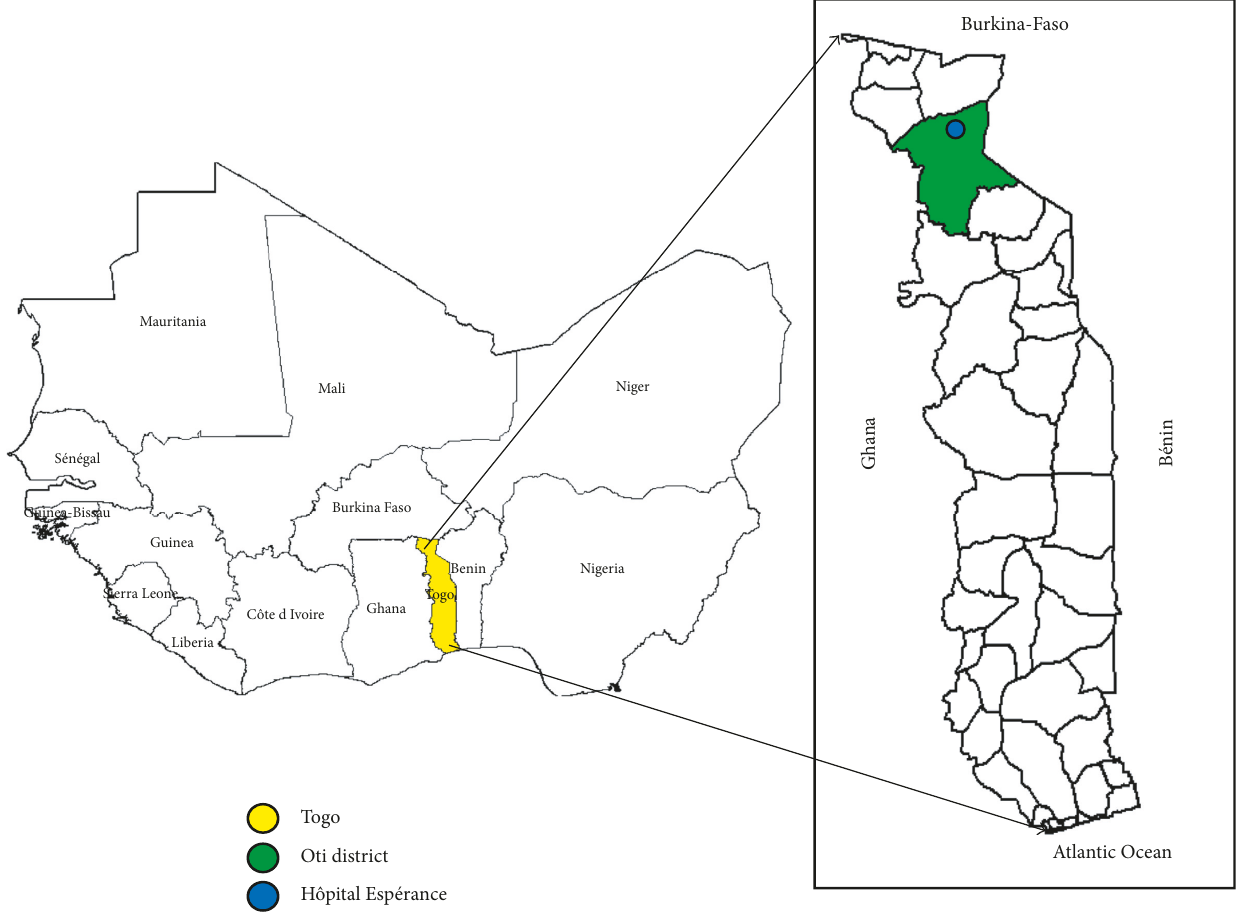
Figure 1: Geographical location of Oti district where “Hˆopital de l’Esp´erance” is